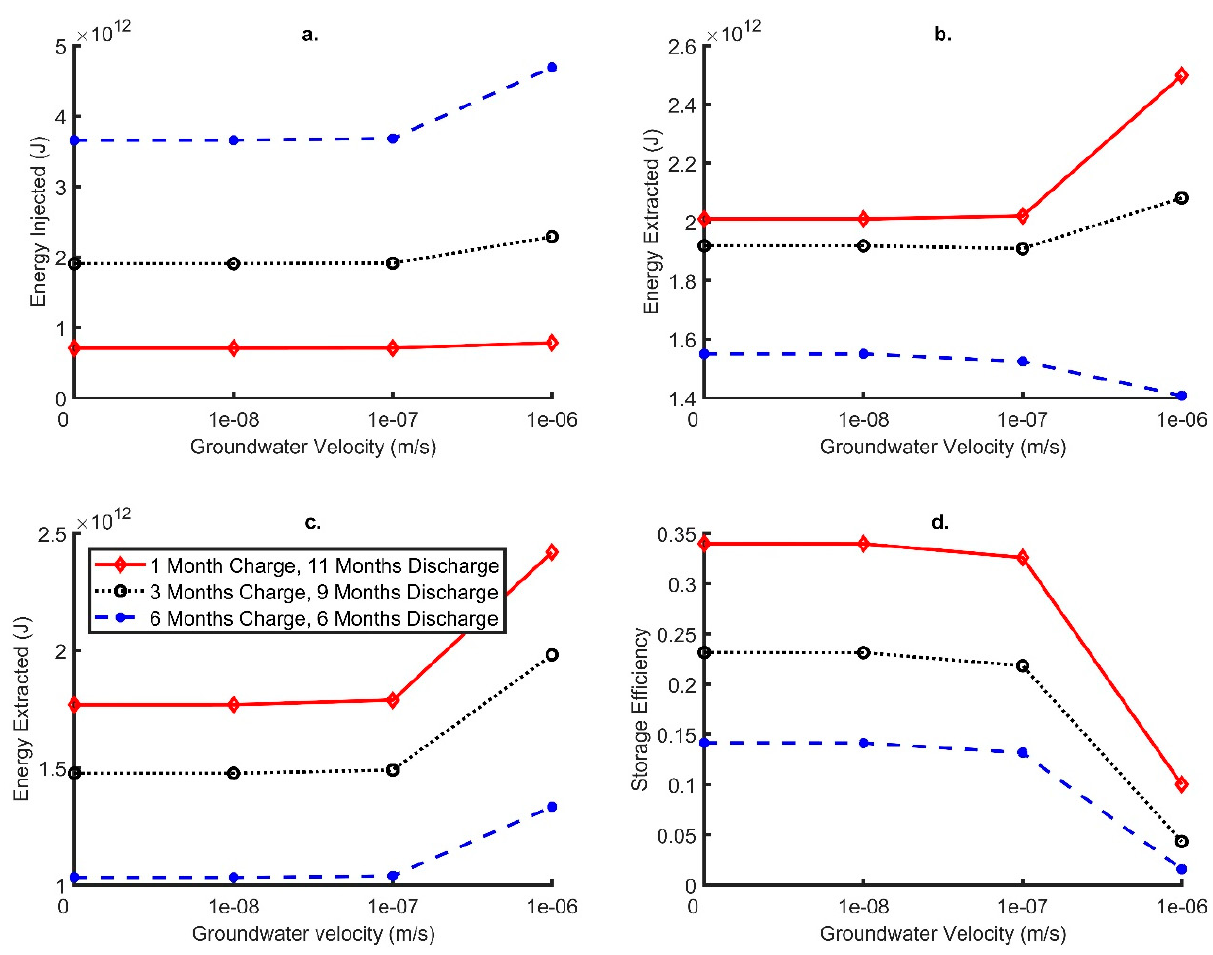
Figure 12. The impact of varying the DBHE charge-discharge cycle duration. Inlet temperature during charge was maintained constant at 95 °C during charge and 5 °C during discharge, with an internal DBHE fluid flow rate of 5 L/s. ( a ) energy injected during charge, ( b ) energy extracted during discharge cycle following charge (respectively 11, 9 and 6 months for 1, 3 and 6 months charge), ( c ) energy extracted without preceding charge during 11, 9 and 6 month periods and ( d ) storage efficiency calculated according to Equation (10).